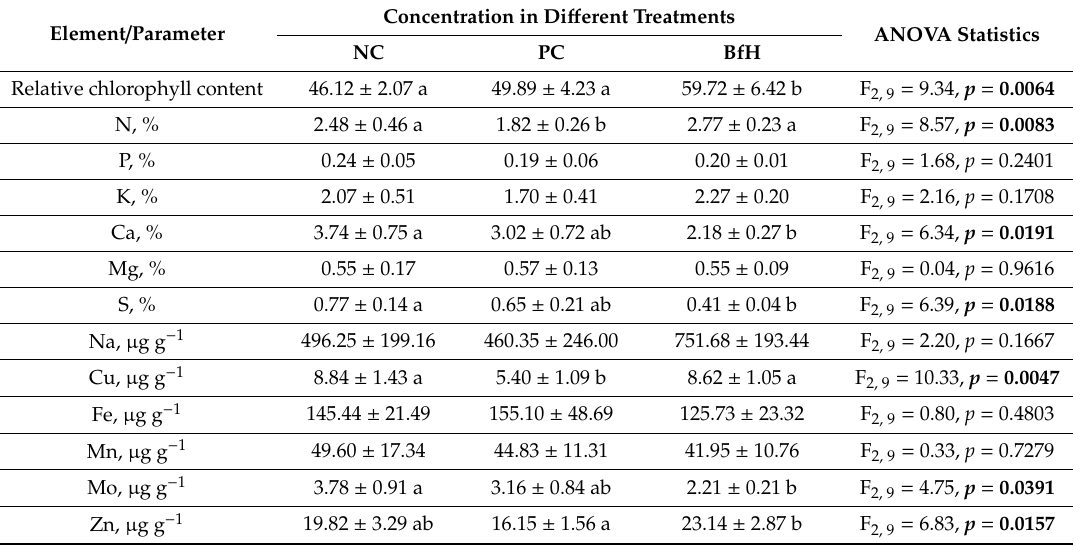
Dataset size for each analysis, n = 12. Data presented as averages with the standard deviation ( ± SD); ANOVA statistic